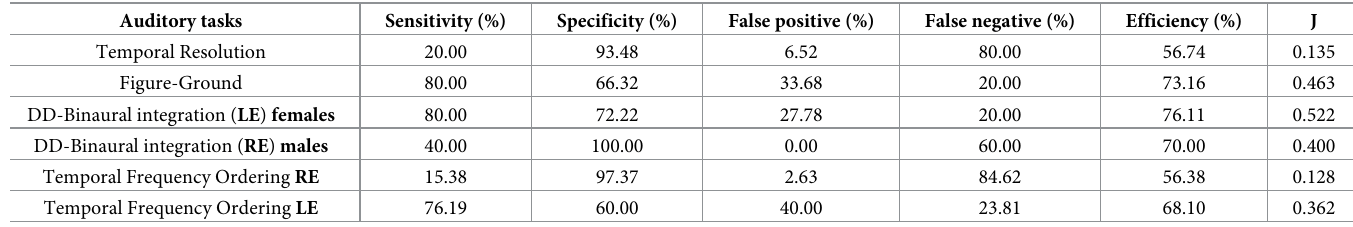
Table 4. Performance of 8-year-old schoolchildren in AudBility and values of sensitivity, specificity, and efficiency. Auditory tasks Figure-Ground DD-Binaural integration ( RE )